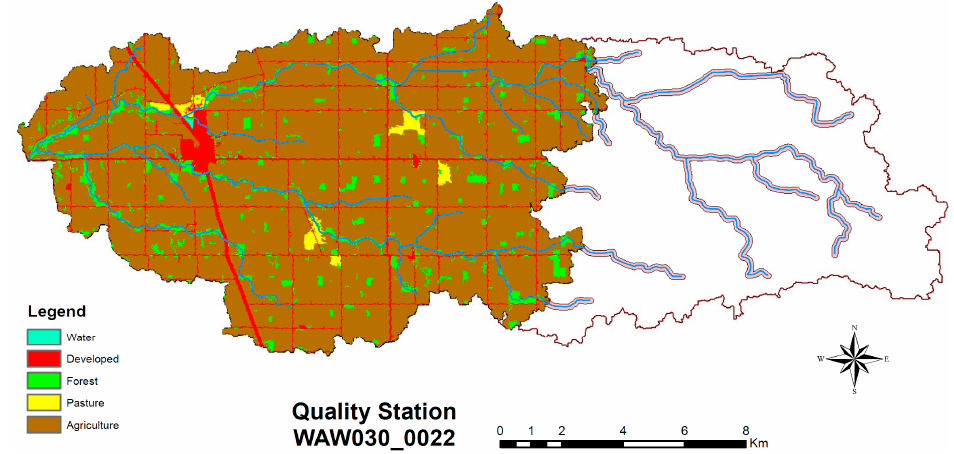
Figure 3. Schematic diagram of three spatial scales: 1. Reach (left side), 2. Riparian (right side), 3. Watershed (brown), for WAW030_0022.